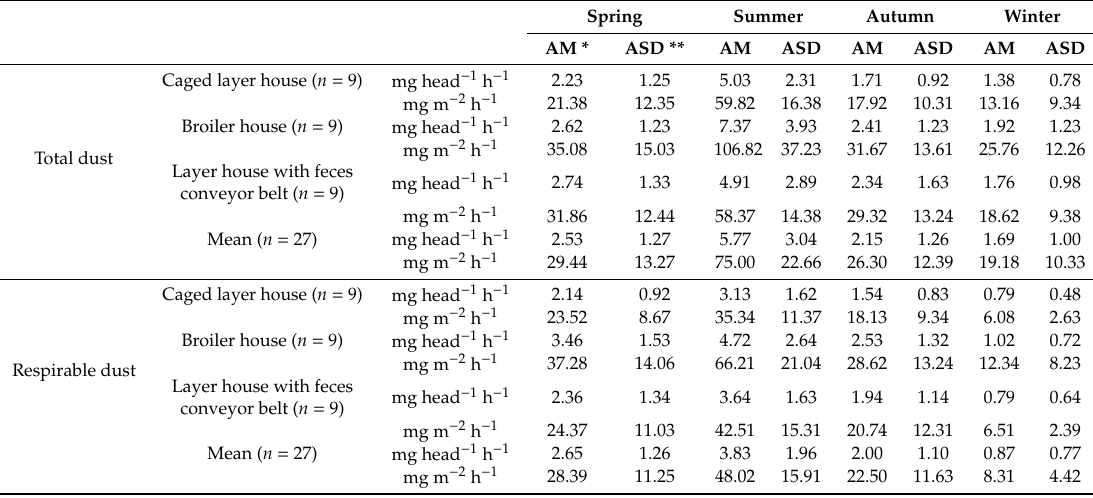
Table 4. Seasonal emission rates of total and respirable dust in poultry